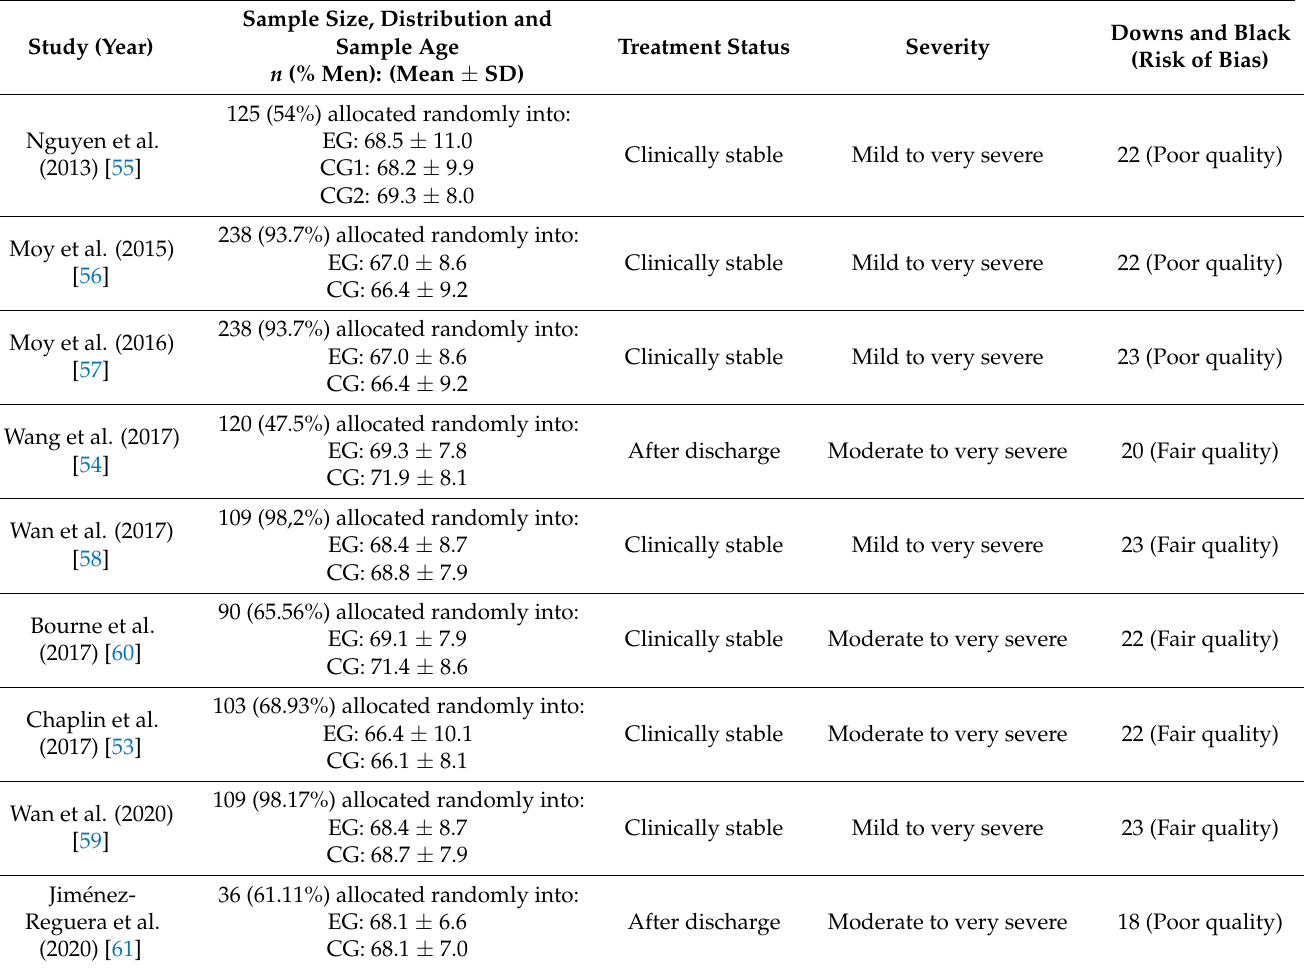
Table 1. Characteristics of the included